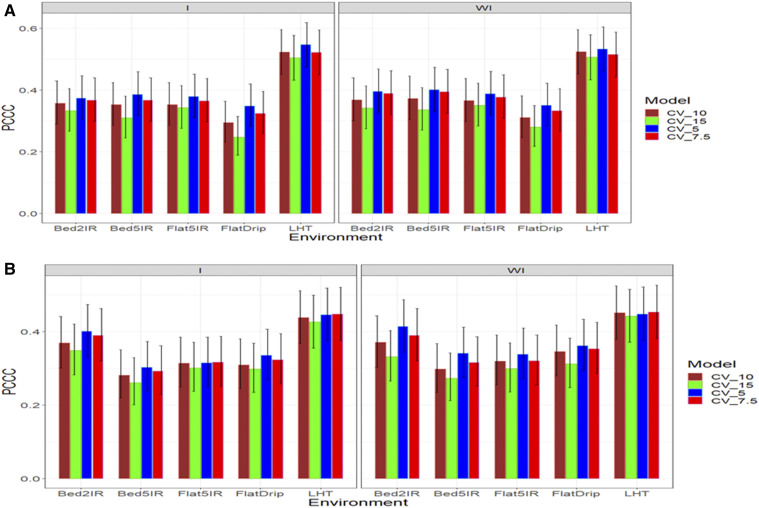
Prediction performance of the proposed MAPT model in terms of proportion of cases correctly classified (PCCC) for traits: A) DTHD and B) DTMT of data set 3, under four values of coefficient of variation (CV). The smaller the CV, the more informative the prior. The left panel is with interaction (I) and the right panel is without interaction (WI).